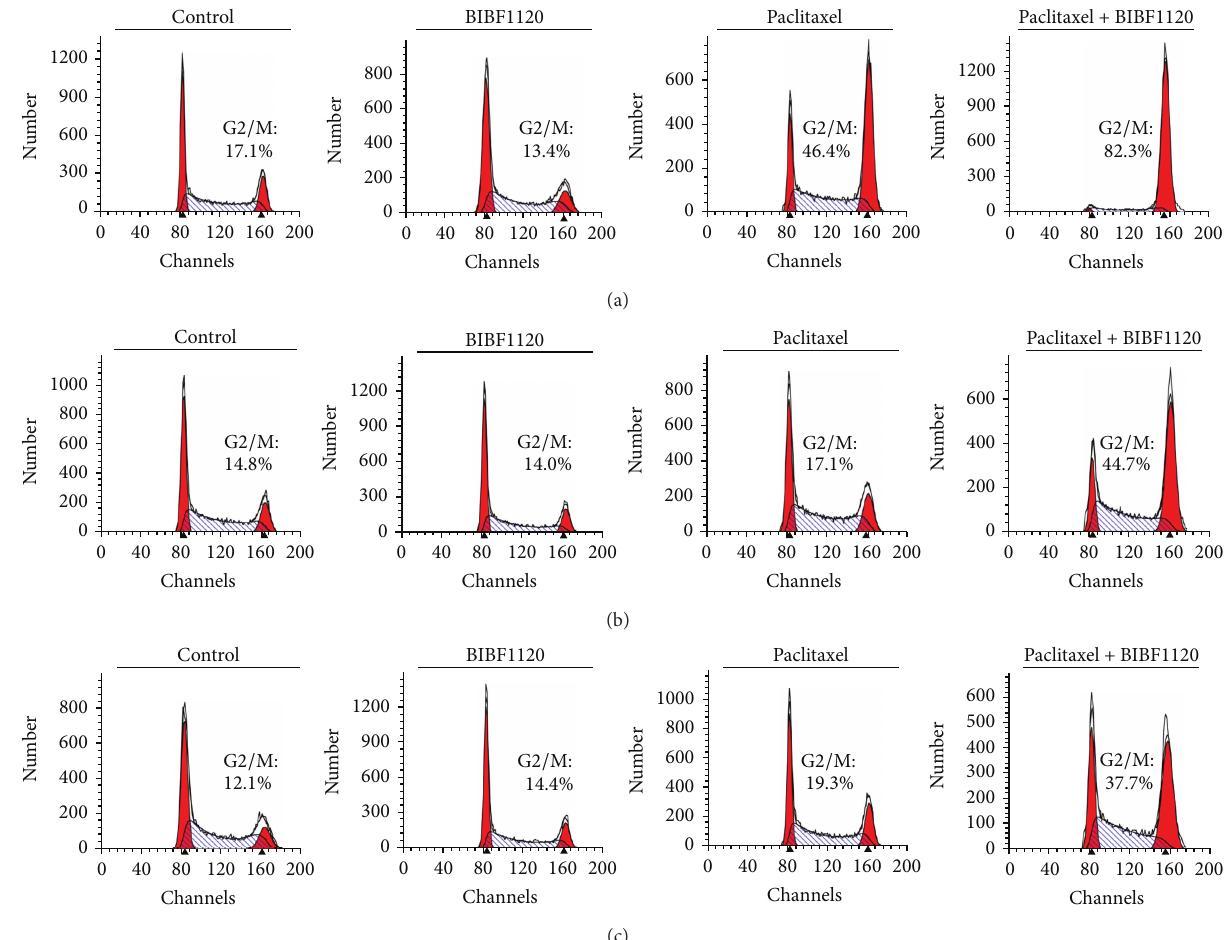
Figure 3: Combination of BIBF1120 and paclitaxel produces a profound increase in the percentage of cells in G2/M. Cell cycle profiles of parental (a) and paclitaxel-resistant Hec50A (b) and Hec50E (c) cells after treatment with 1 𝜇 M BIBF1120, 14nM paclitaxel, or the combination for 24h. The percentage of cells in G2/M is indicated in each